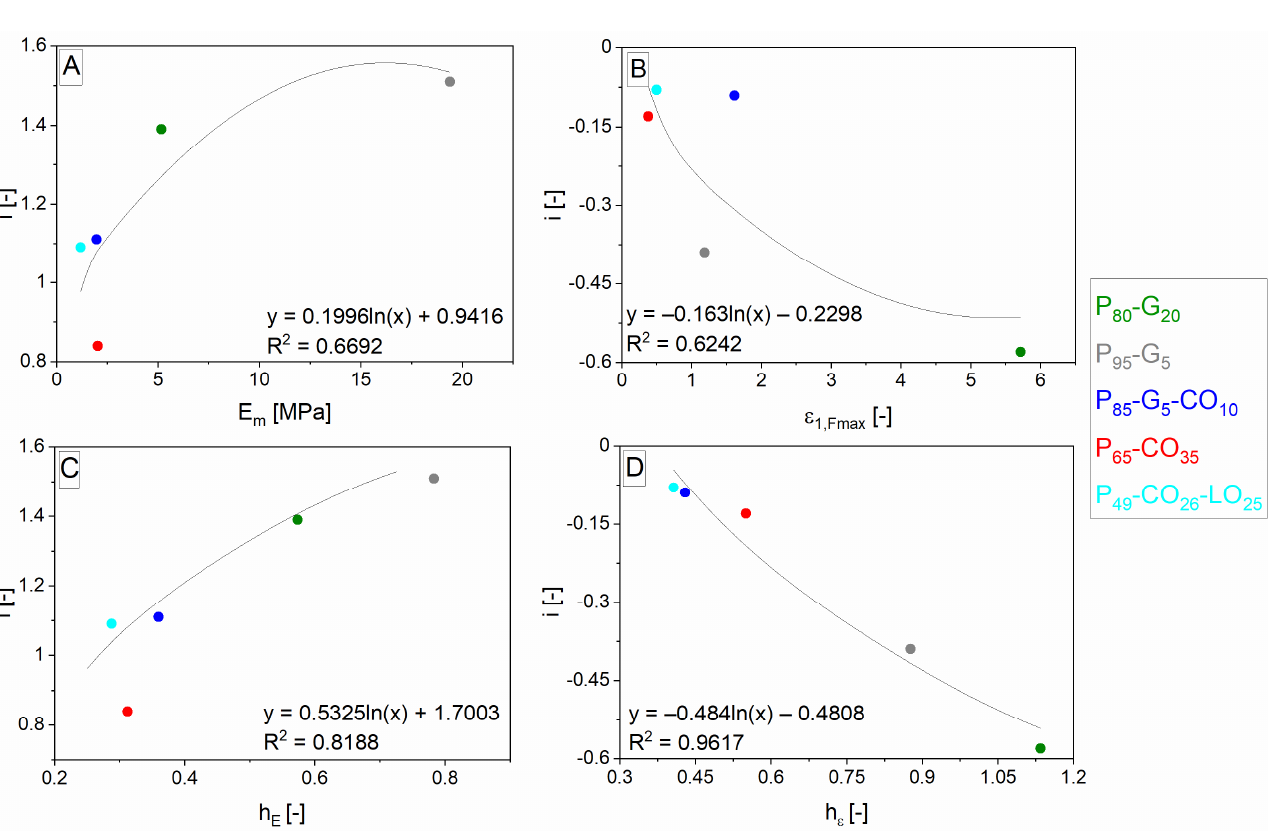
Figure 3. Dependences corresponding to relations (25) ( A ) and (28) ( B ). The symbol h with subscript labeling the property is the slope of dependence describing the correction parameter η in the mixing rule . The symbol h is here described by polyurethane matrix properties. Matrices designation is composed of components labeled P (polyurethane pre-polymer), G (glycerol), CO (castor oil), and